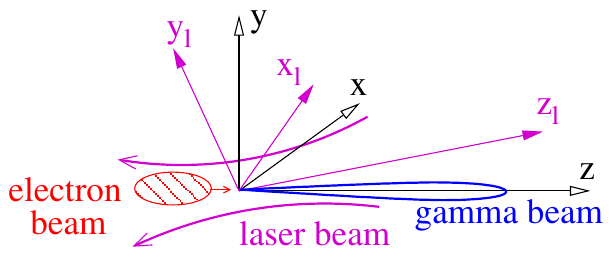
FIG. 8. Compton scattering of a pulsed electron beam and a pulsed laser beam in the laboratory frame. Two coordinate systems are defined to describe electron and laser beams: the first coordinate system ð x; y; z Þ is the electron-beam coordinate system in which the electron beam is moving along the z -axis Þ system is the laser-beam coordinate ; y ; z direction; the ð x l l l system in which the laser beam propagates in the negative z -axis direction. The coordinate systems ð x; y; z Þ and ð x l share the same origin.